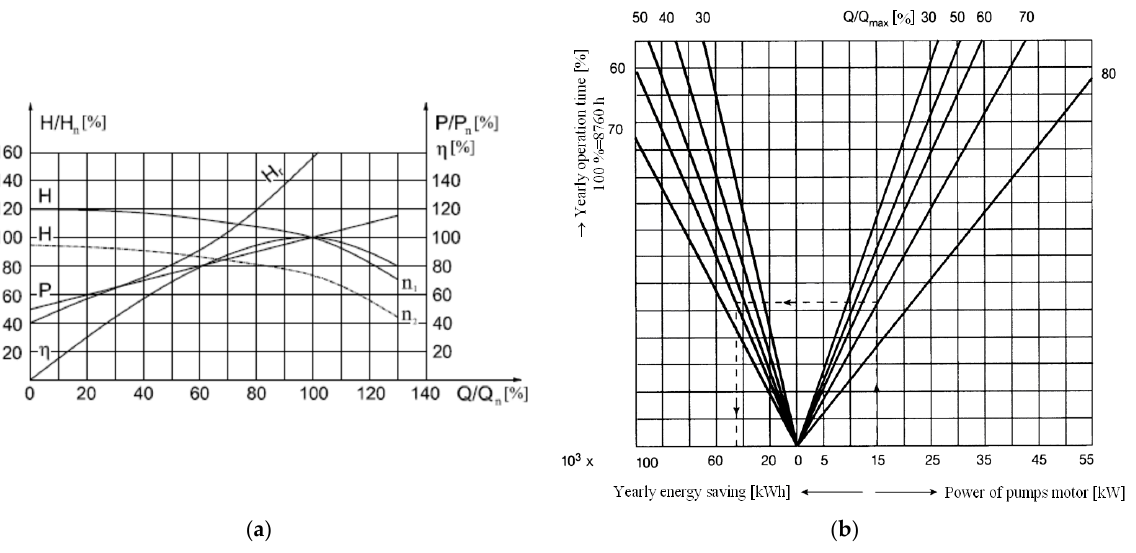
Figure 19. ( a ) Variation in an HS pump’s power; ( b ) Annual energy savings using variable-speed pumps (VSPs) [123].